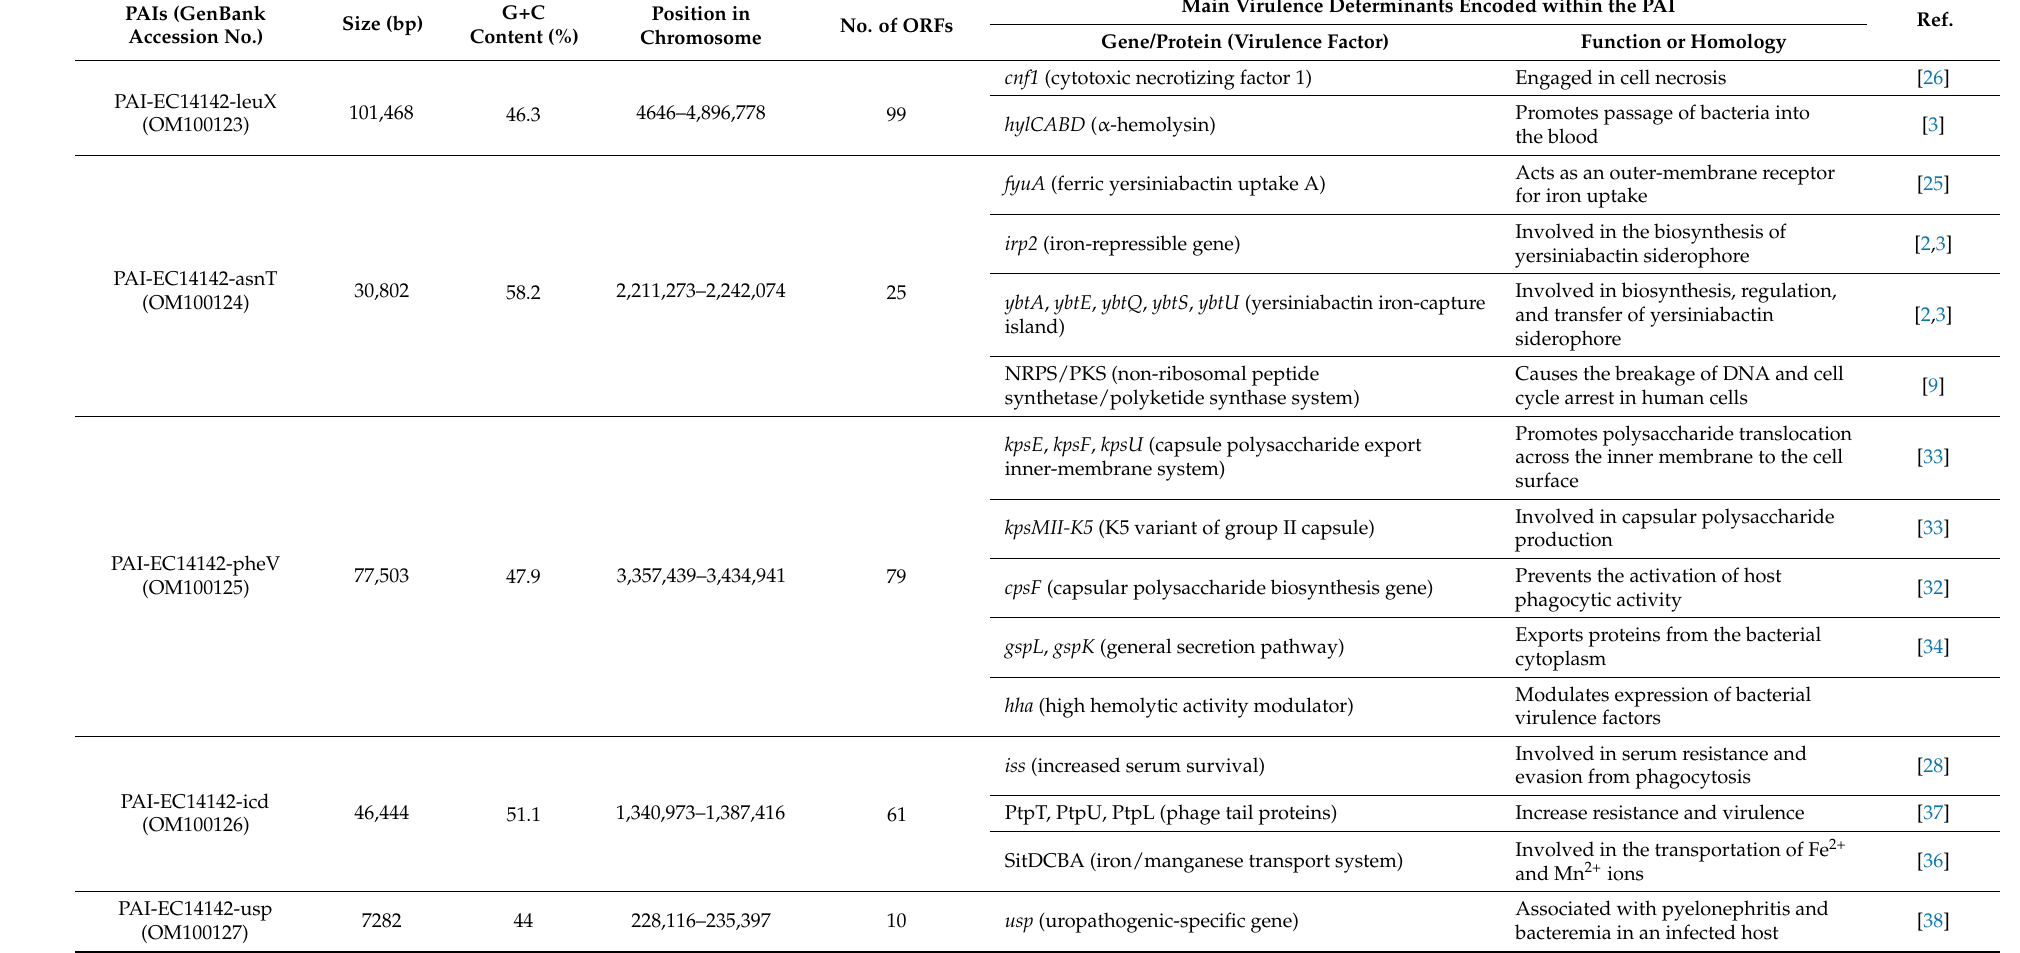
Table 3. Features of pathogenicity islands carried on EGY_EC14142 chromosome of UPEC isolate EC14142 from Egypt. PAIs (GenBank Accession